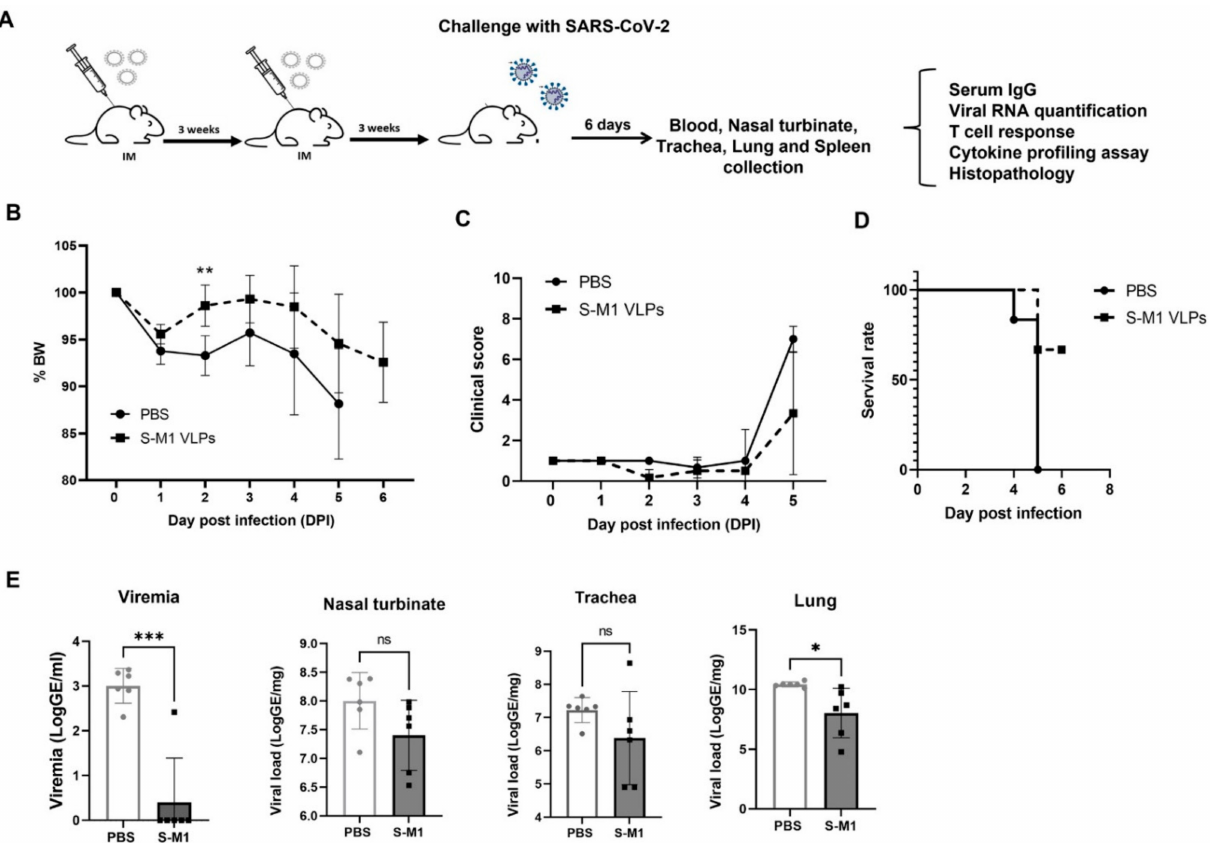
Figure 5. Efficacy of VLP vaccine in K-18 mice. ( A ) K-18 mice were immunized on days 0 and 21 with either PBS or S-M1 VLP mixed with alum. Three weeks after boosting, mice were challenged with live SARS-CoV-2 virus. After sacrifice, various organs were collected for further testing. ( B , C ) After the challenge with live SARS-CoV-2 virus, mice were examined daily for ( B ) weight changes and ( C ) physical and behavioral signs of disease, which were scored on a scale from 0 to 10. 0 indicates no indication of disease. ( D ) Survival rates for calculated for each test group over the 6 days before sacrifice. Mice meeting humane endpoints were sacrificed before the experimental